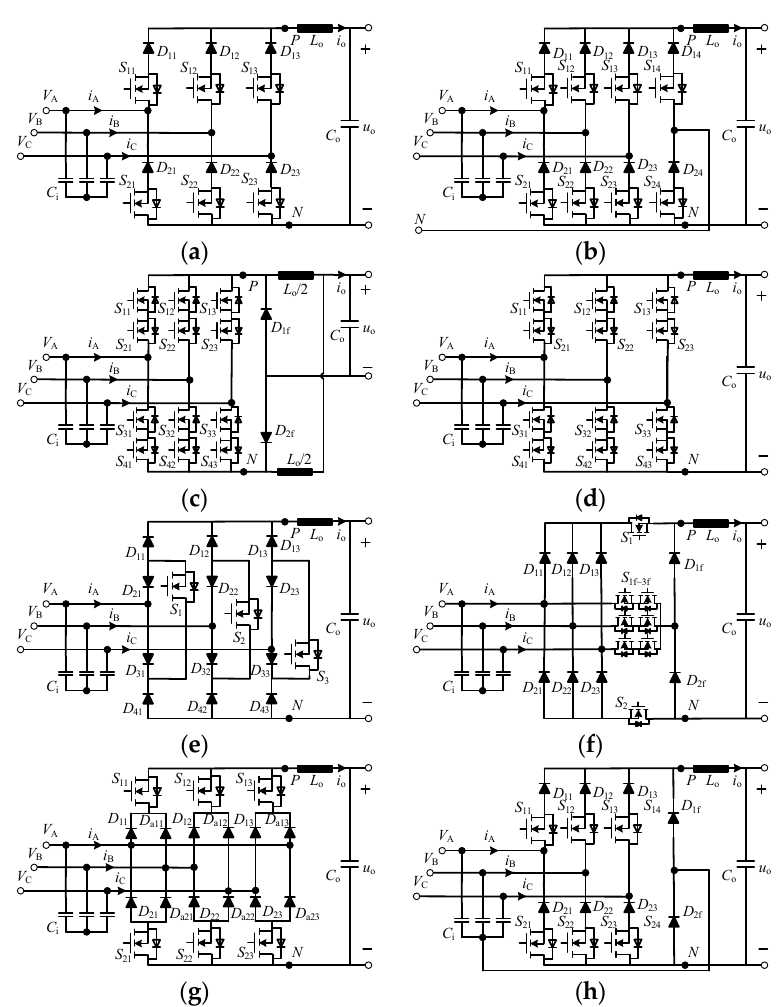
Figure 10. Topological structures. ( a ) Six-switch CSR. ( b ) Three-phase four-wire CSR. ( c ) Current doubler CSR. ( d ) Matrix-type CSR. ( e ) Three-switch CSR. ( f ) Swiss-type CSR. ( g ) Delta-type CSR. ( h ) Split freewheeling diode CSR. Table 4. Comparative analysis of the CSRs. Number of